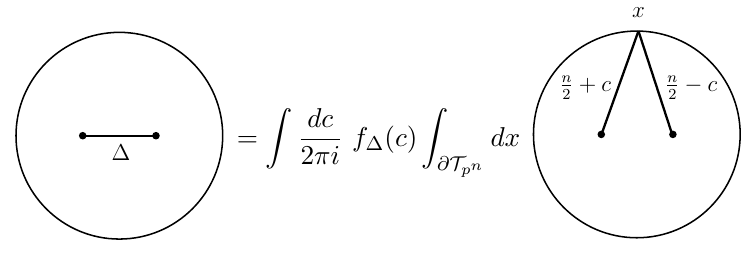
Figure 5 . The split representation eq.